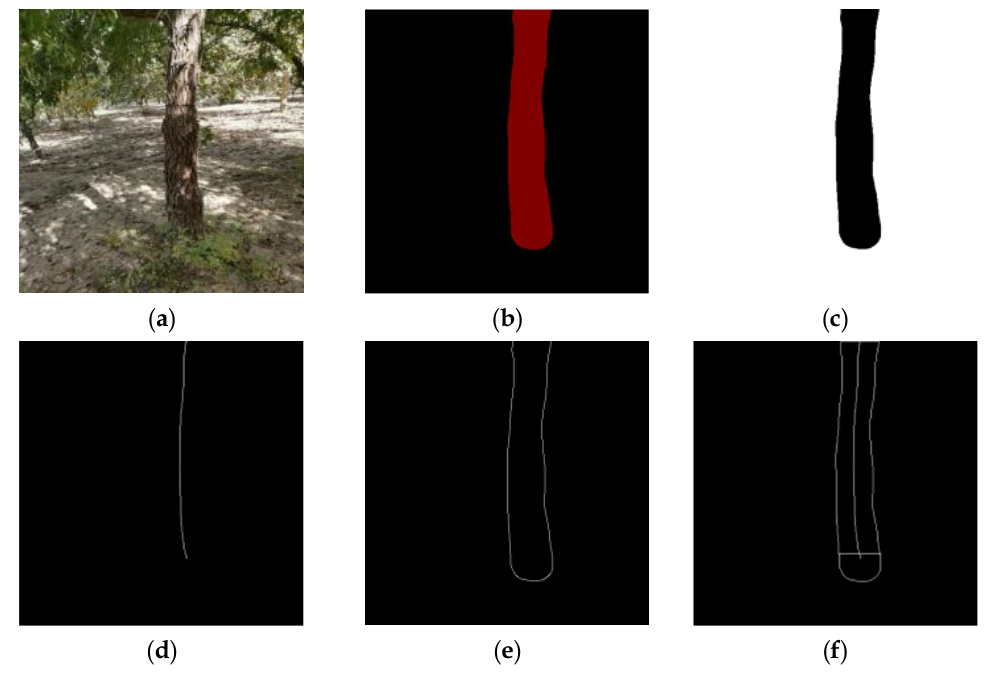
Figure 11. Trunk diameter measurement. ( a ) The original image of red jujube trunk. ( b ) The image resulting from the improved trunk segmentation algorithm. ( c ) The image resulting from image preprocessing. ( d )The image resulting from centerline extraction. ( e ) The image resulting from edge extraction. ( f ) The image resulting from Intersection point calculation.